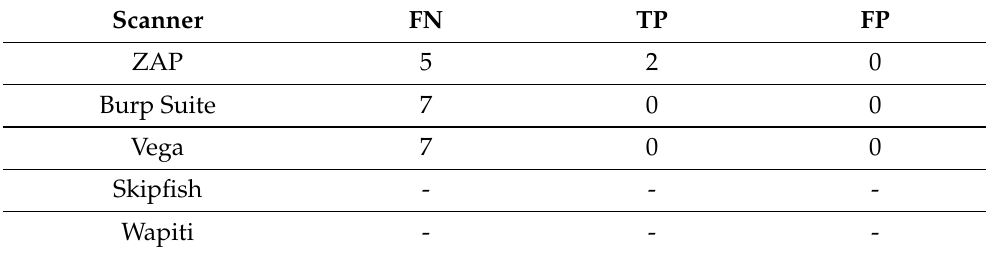
Table 6. FN, TP, and FP results in mode 3.